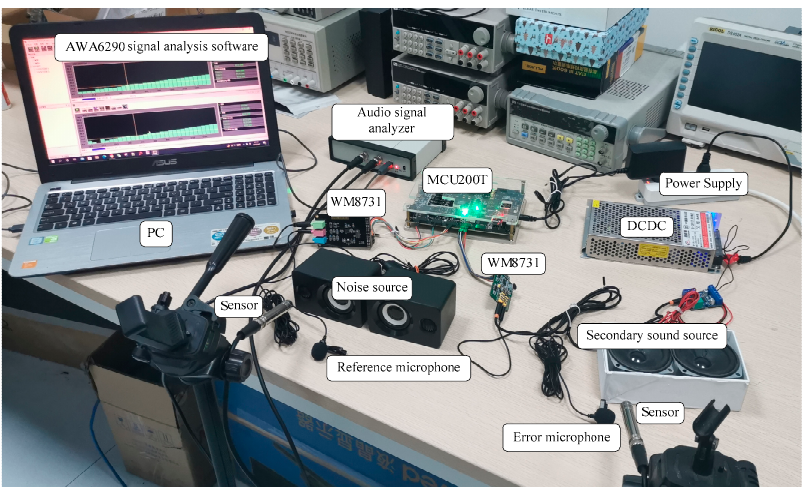
Figure 12. Real scene diagram of test scene.